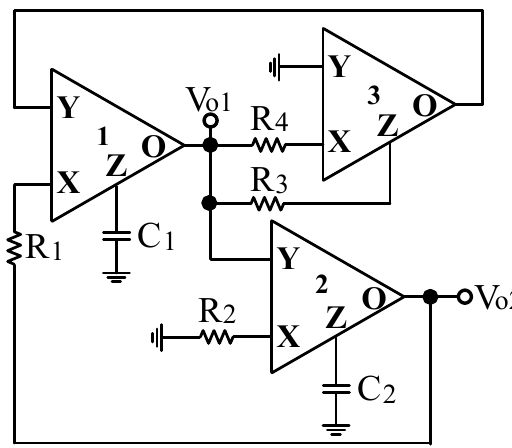
Figure 4. The proposed VM QO with fully-uncoupled controlled of CO and FO.